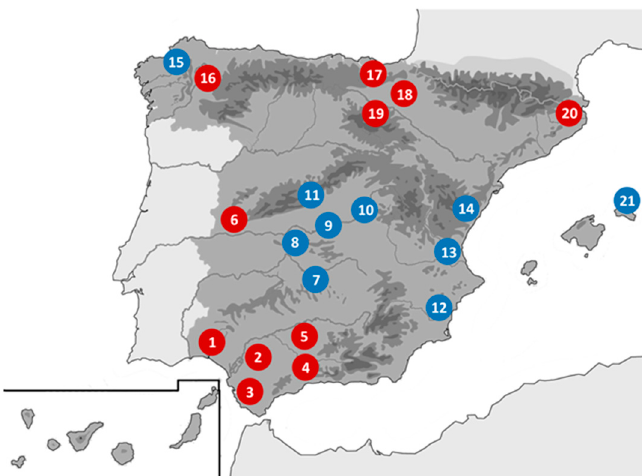
Figure 1. Geographical distribution of Bat capture locations in Spain. South of Spain: 1. Huelva, 2. Seville, 3. Cádiz, 4. Málaga, 5. Córdoba. Centre of Spain: 6. Cáceres, 7. Ciudad Real, 8. Toledo, 9. Madrid, 10. Guadalajara, 11. Segovia, 12. Alicante, 13. Valencia, 14. Castellón. North of Spain: 15. A